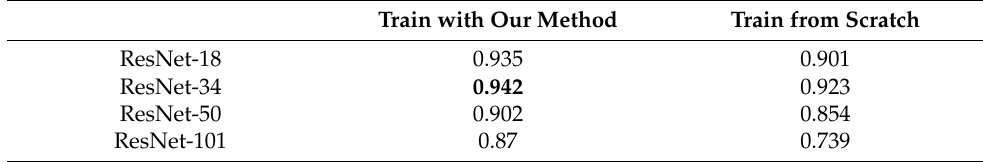
Table 3. Ship detection results (AP) of different structures of